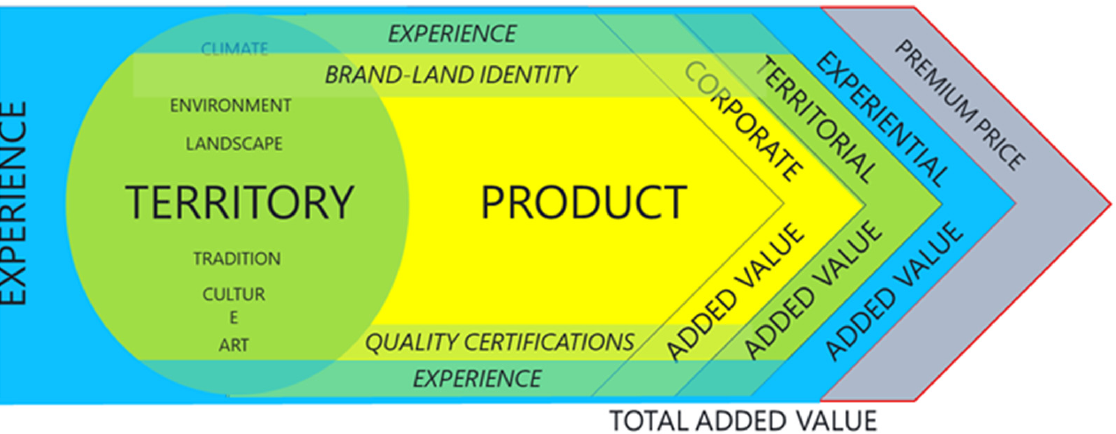
Figure 4. Authors elaboration of an integrated value chain that starts from the Porter’s product value chain. In this model, the original value chain is integrated with the experience and territorial elements that provide further value to the wine. Source: Own elaboration.